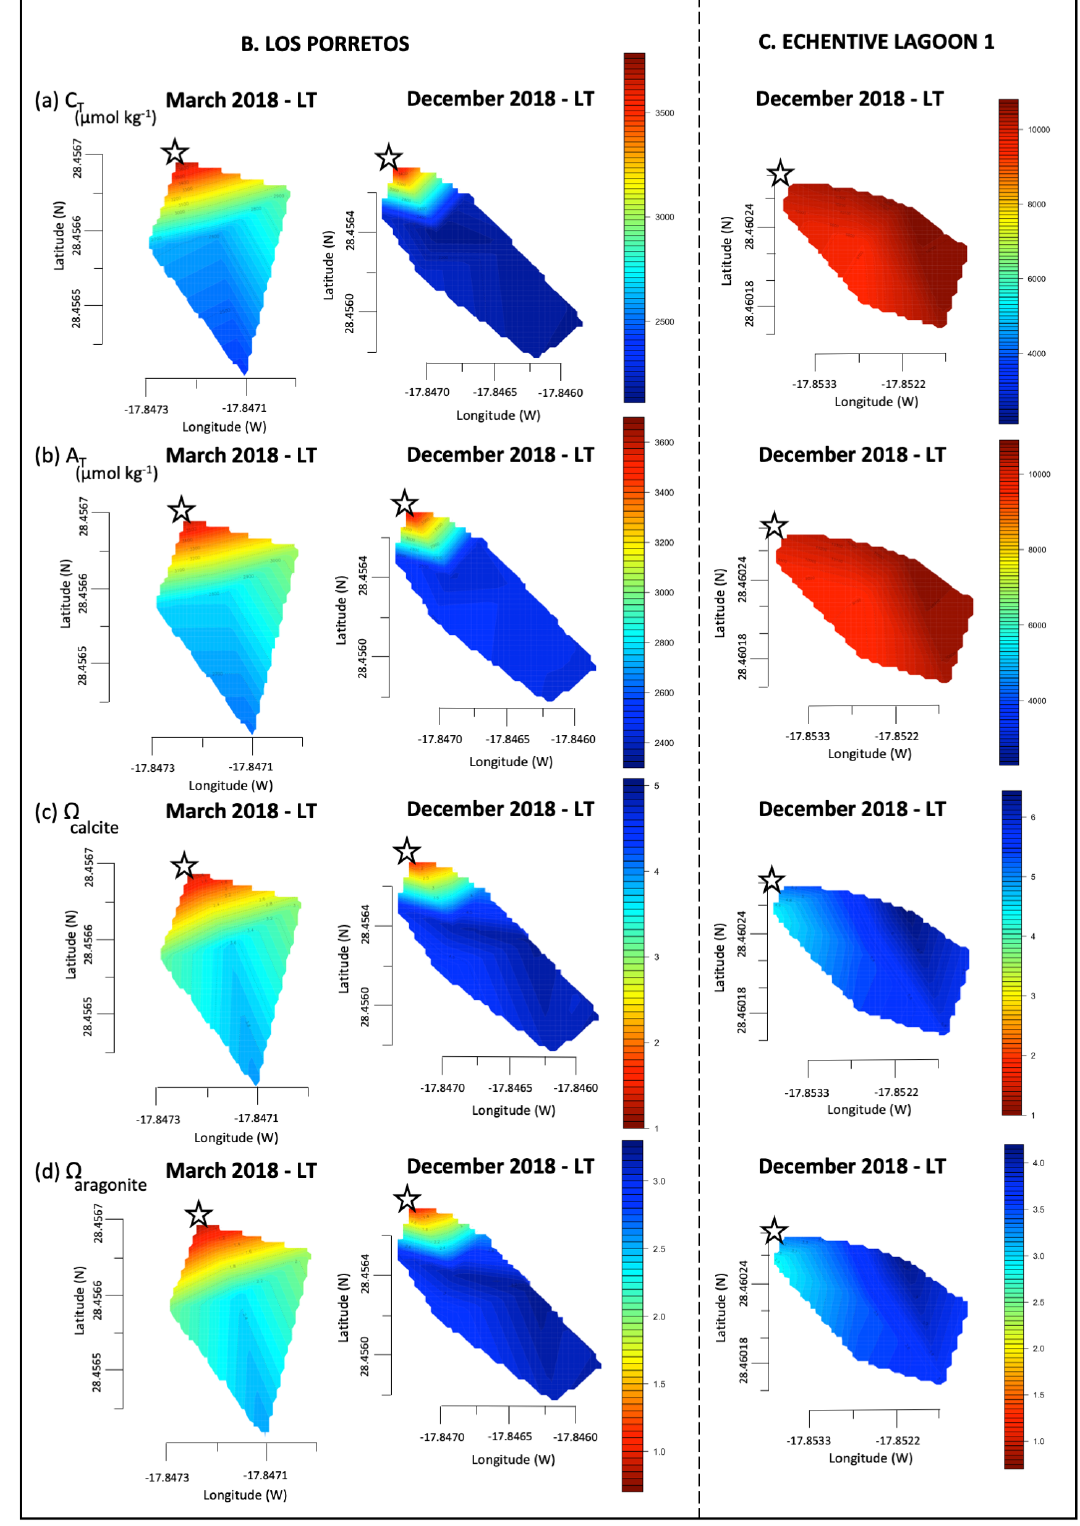
Figure 4. Linear interpolation graphs of C T (a) , A T (b) , (cid:127) calcite (c) and (cid:127) aragonite (d) values during March and December 2018 during low tide (LT) on Los Porretos (B) and in Echentive lagoon 1 (C). The star symbol is the reference mark on the map in Fig.